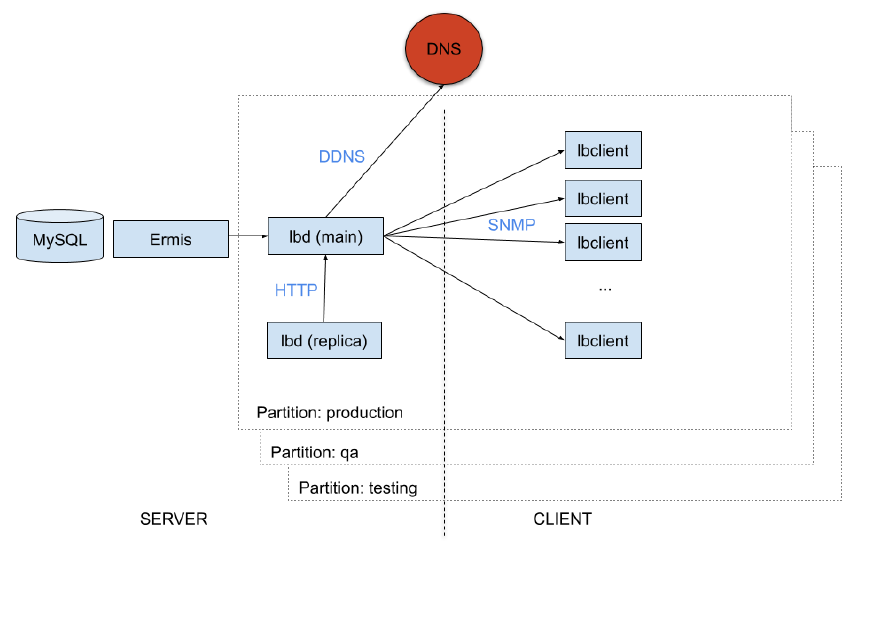
Figure 1. Components of the load balance